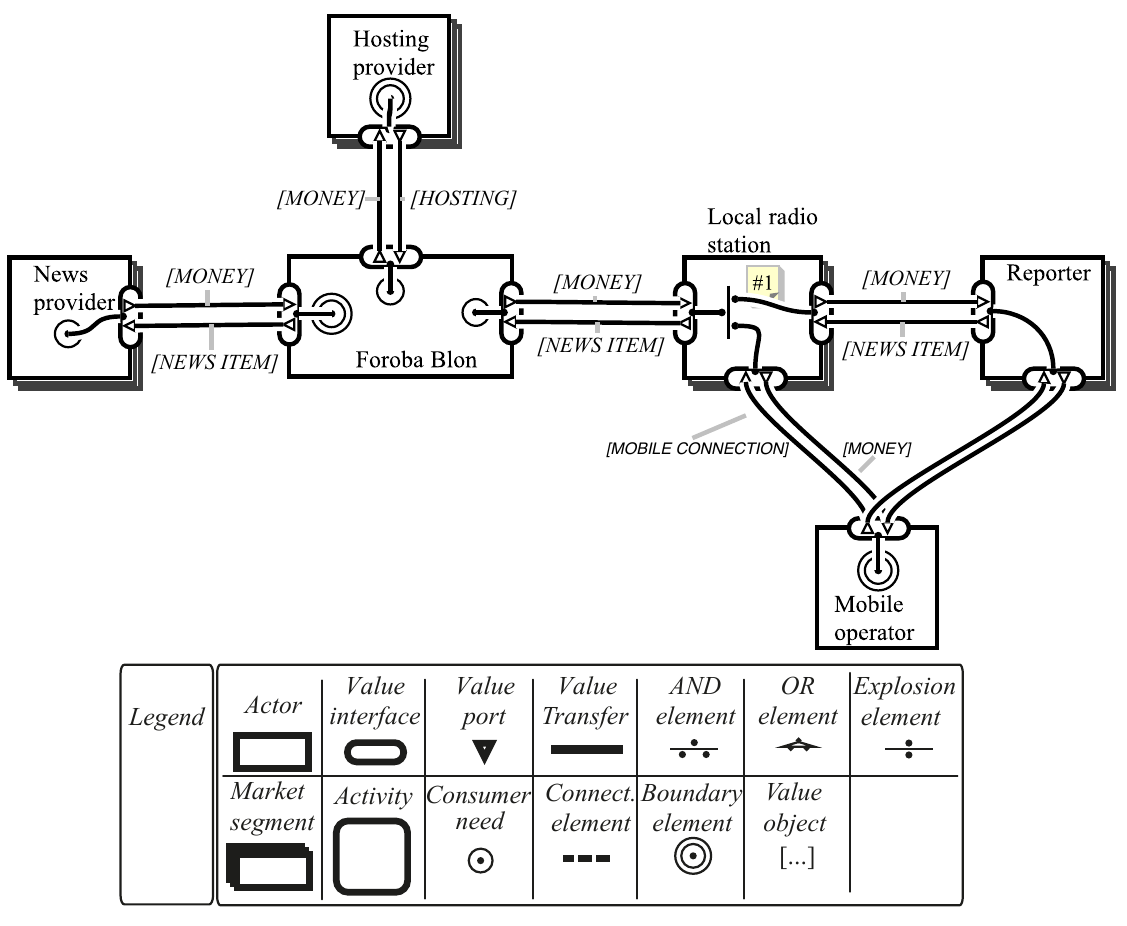
Figure 9. The news provider pays for obtaining regional news